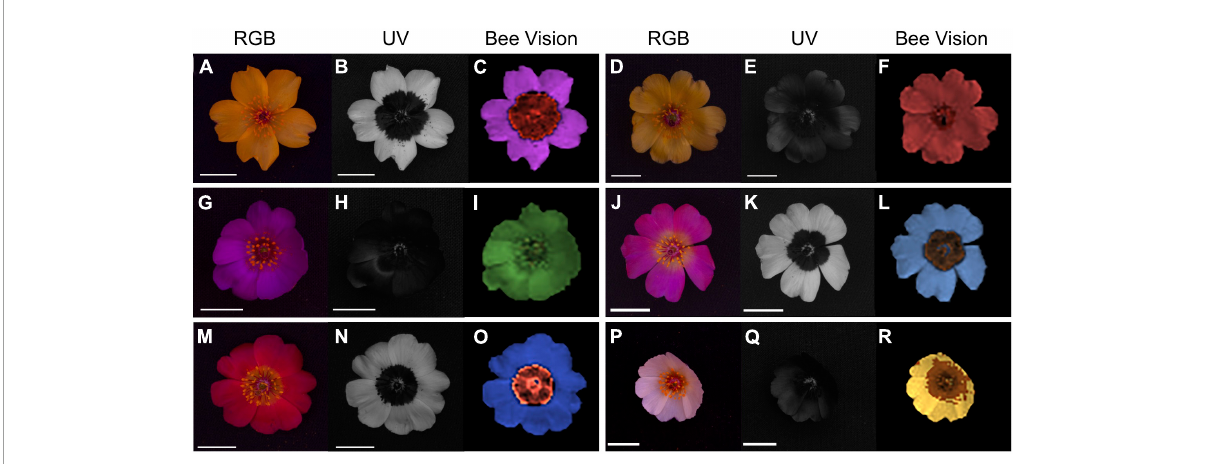
FIGURE4 Color varieties of Cistanthe longiscapa flowers shown in RGB (A , D , G , J , M , P) , and UV photographs (B , E , H , K , N , Q) and images represented as they would be seen through the eyes of honeybees (C , F , I , L , O , R)